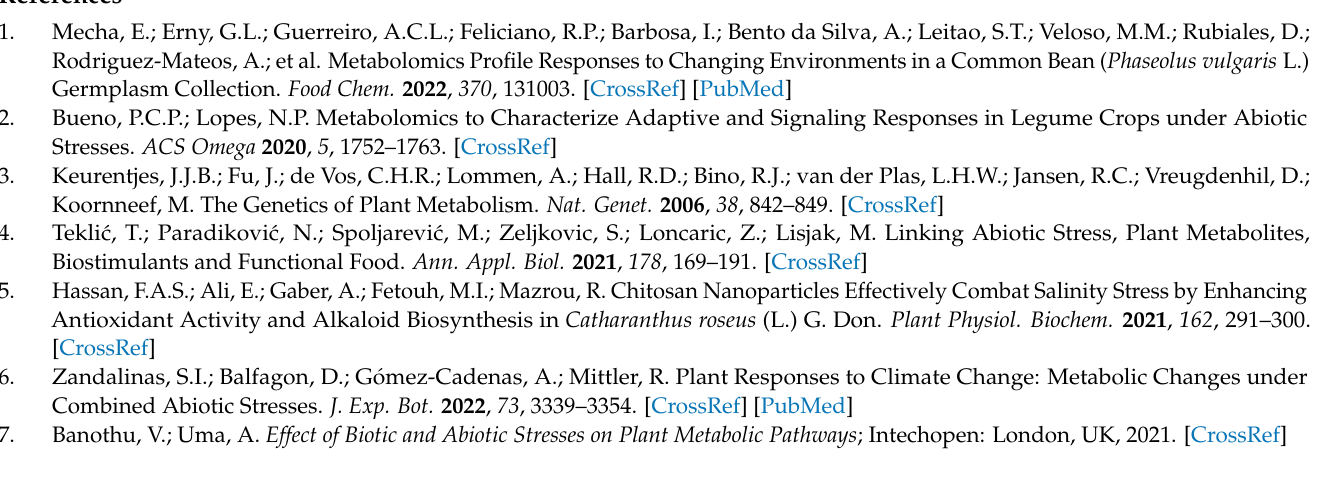
of experimental design. Figure S3: Estimation of starch, protein contents and lipid percentage of genotypes. Mean values of three biological replicates with standard errors. Figure S4: Comparative accumulation of metabolites across genotypes with a fold change >2. Yellow indicates the common metabolites identified across genotypes. Green indicates the specific metabolites identified in each comparison. Figure S5: PLS-DA and OPLS-DA score plots of each comparison in both ionization modes showed clear separation of tolerant and sensitive genotypes for each comparison. Table S1: Listed below are the common bean genotypes and races grown in the field and subjected to terminal drought stress. Table S2: Mean yield (lbs/acre), days to flowering and maturity and 100 seed weight (SW) of the six genotypes evaluated near Scottsbluff, Nebraska, USA. Table S3: List of the metabolites obtained through negative and positive ionization modes provided in the table along with fold change and p values. Table S4: List of the metabolites with fold change >2. Across all genotype comparisons, negative ionization metabolites were found to be higher. Table S5: Variable importance in projection (VIP) > 1.5 was used in order to filter out metabolites significantly different between the tolerant and sensitive genotypes. In total, 79 metabolites were identified in negative ionization mode and 61 metabolites in positive ionization mode. The genotype SB-DT2 (C1 vs. Z1) contained more metabolites than the other genotypes. Table S6: Inferred metabolic pathway from accumulated metabolites using KEGG databases. There were more metabolic pathways associated with genotype SB-DT2. No pathways were found for SB-DT3 in the positive ionization